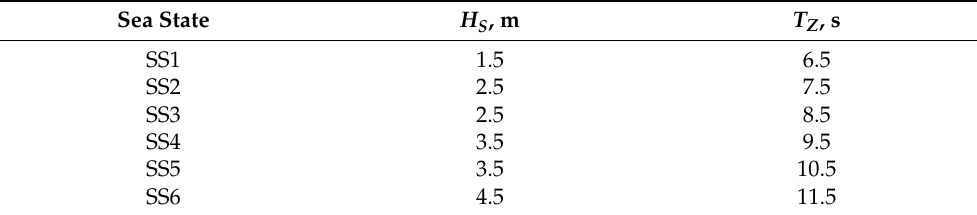
Figure 12. The comparison of the desired outputs, d(n) and the ones obtained by ANN, O(n) for testing data. Table 5. The significant wave height and wave period for analysed sea